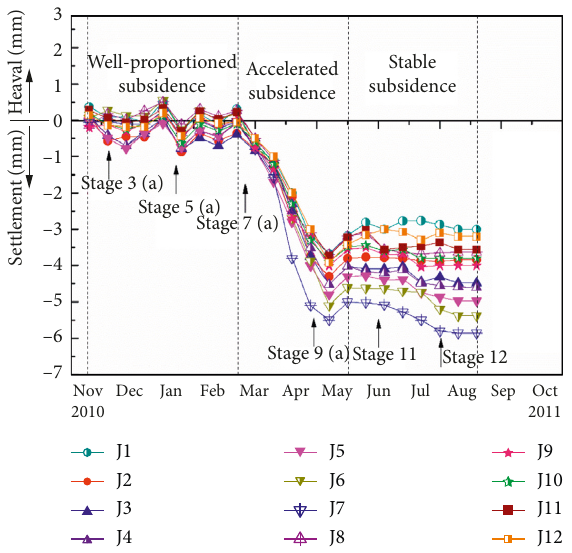
Figure 19: Settlement developments of adjacent Unicom